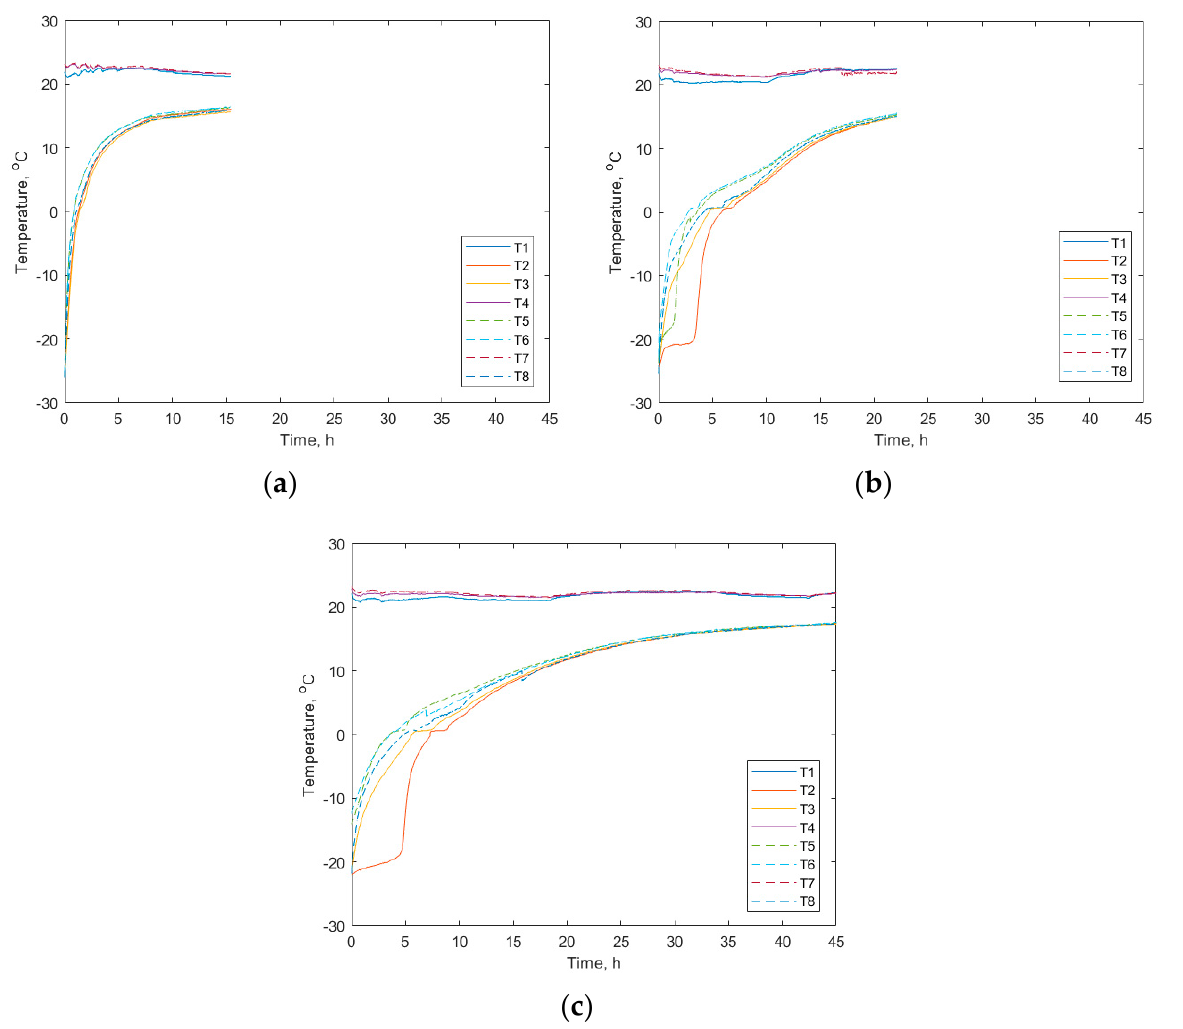
Figure 6. The plot of temperature changes at all measurement points during the test of: ( a ) the reference wall without the layer of phase change material; ( b ) the wall with a 6 mm layer of phase change material; ( c ) the wall with a 10 mm layer of phase change material.